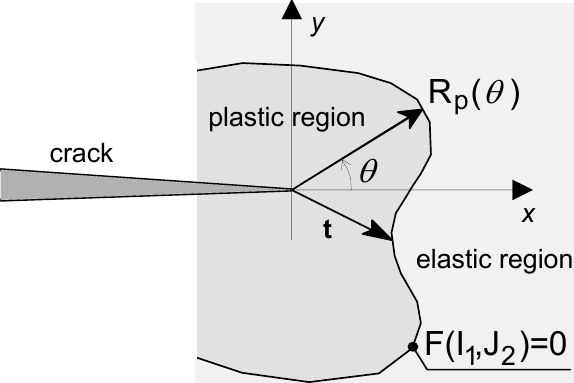
Figure 8: Graphical representation of the